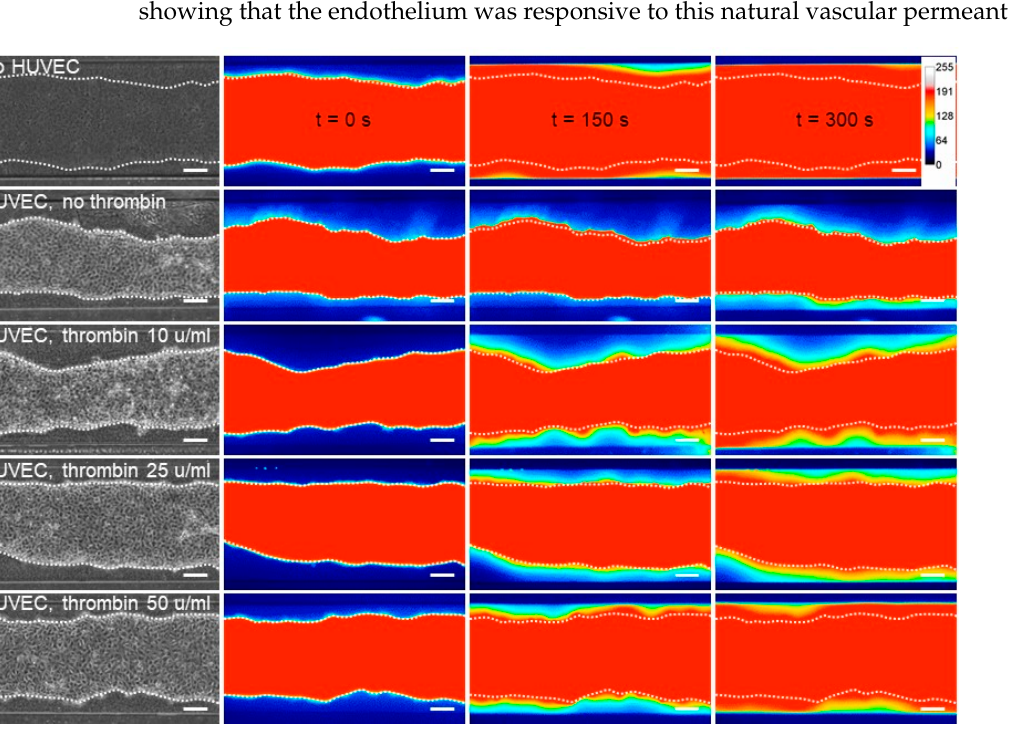
Figure 6. Permeability assay on VoC. Diffusion of 70 kDa dextran-FITC into the collagen layer overtime, depending on the received dose of thrombin injected. No HUVEC—collagen channel not lined with endothelial cells; HUVEC—channels lined with endothelial cells, n = 3 VoC per condition, bar = 200 µm. Images were extracted from video recordings at 0, 150 s or 300 s after dextran-FITC injection. Heatmap represents fluorescent intensity of 70 kDa dextran. Fifteen VoC were processed at a time in this representative experiment.